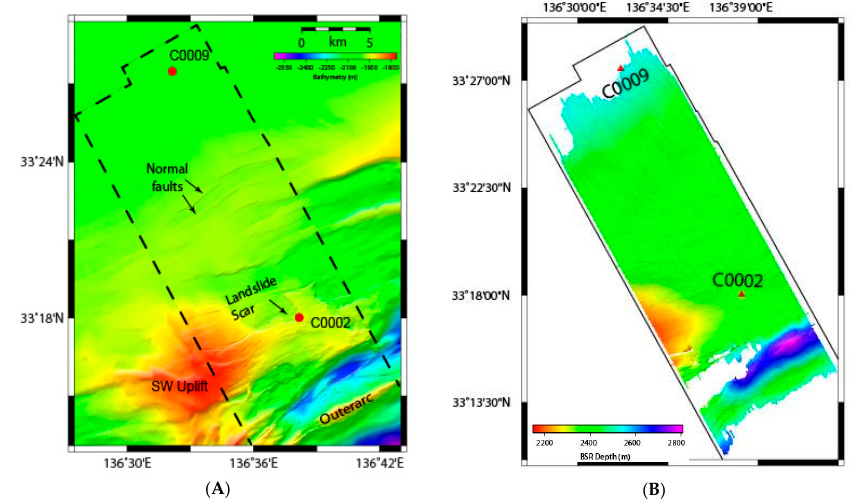
Figure 3. ( A ) Bathymetric map of the study zone for reference; ( B ) BSR depth map in meters below sea-level. Red triangles represent drill Sites C0009 and C0002. The BSR generally mirrors the seafloor behavior and is continuous across the large normal faults. Blank zones in the BSR map within the survey regions are areas where BSRs were not imaged in the seismic